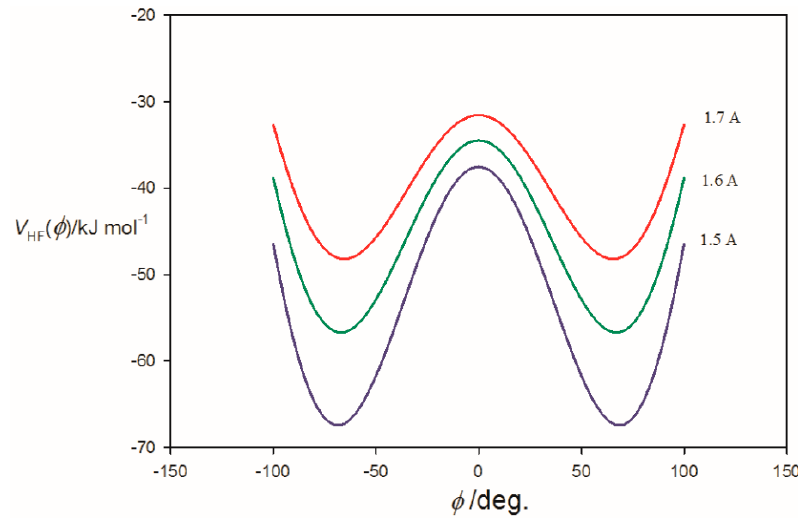
Figure 12. The electrostatic potential energy V HF ( φ ) of HF treated as a simple extended electric dipole as a function of angle φ at three distances of the H atom of HF from the O atom of oxirane. Table 1. Comparison of properties of cyclic ether · · · HF complexes from ab initio calculations, from rotational spectroscopy, and from an electrostatic model in which HF is treated as an extended electric dipole (see text for discussion of how V HF ( φ ) is calculated by using a DMA of the cyclic ether charge distribution in this